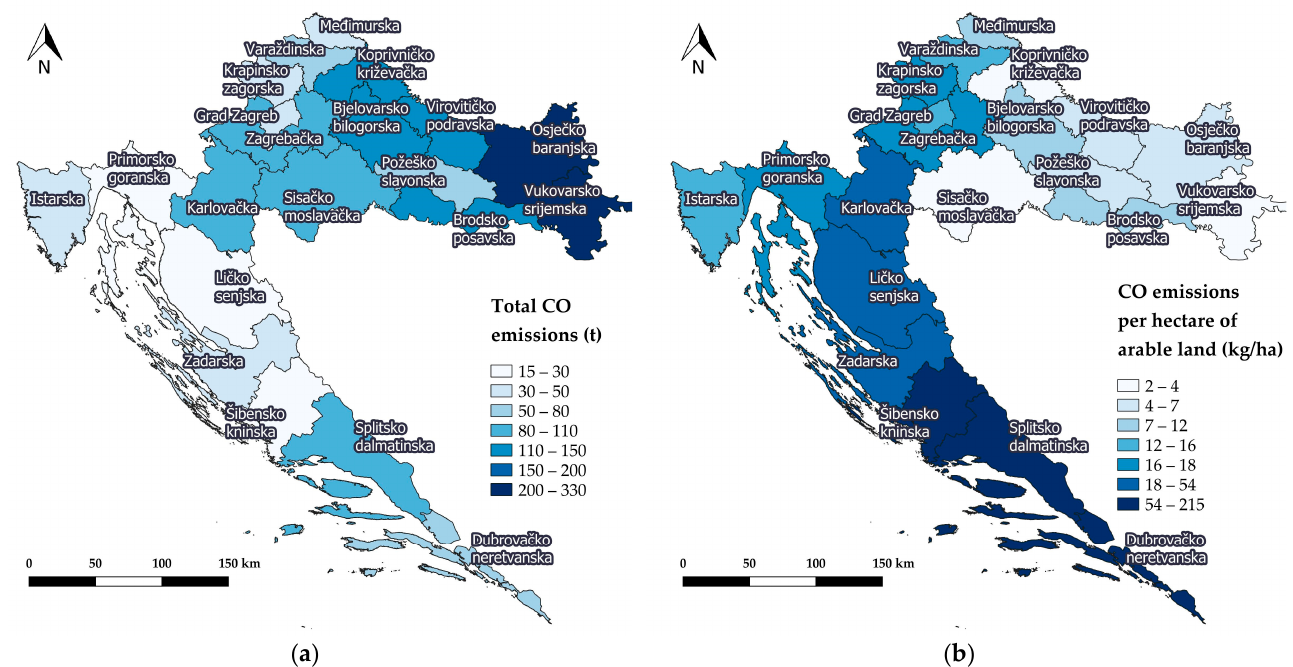
Figure 6. S patial distribution of total carbon monoxide (CO) emissions ( a ) and spatial distribution of CO emissions per hectare of arable land ( b ). CO emissions per hectare of arable land ( b